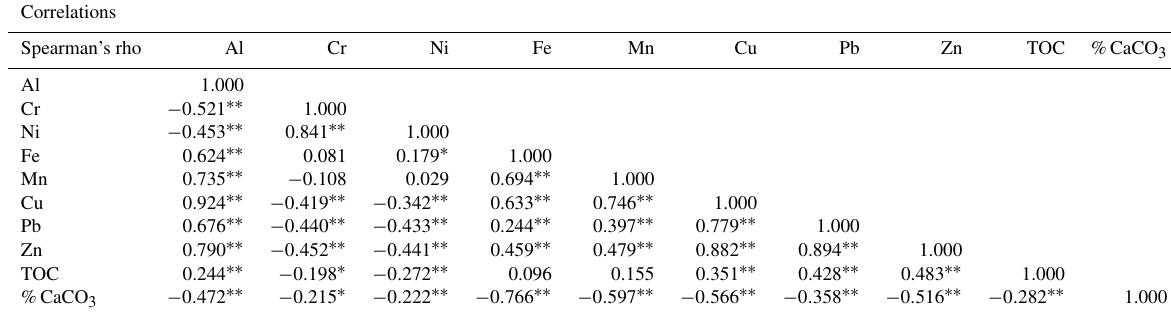
Table A3. Spearman’s correlation coefficient matrix for Al (mgkg − 1 ) , Cr (mgkg − 1 ) , Ni (mgkg − 1 ) , Fe (mgkg − 1 ) , Mn (mgkg − 1 ) ,